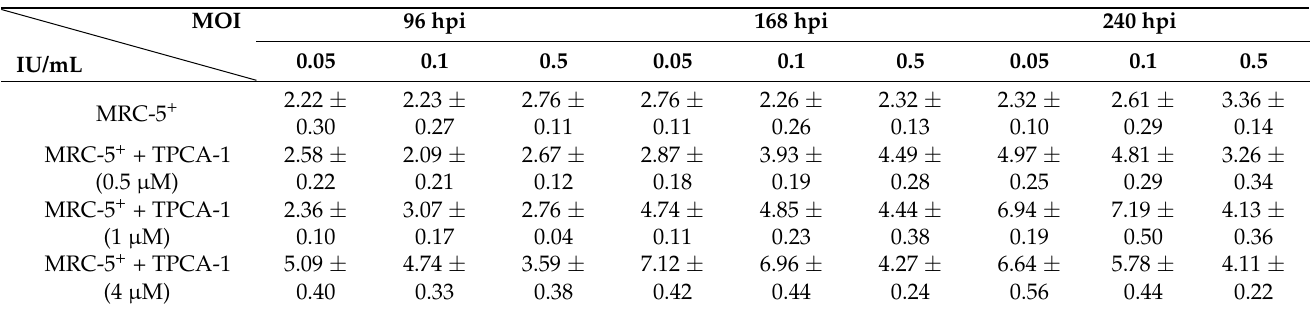
Figure 2. Treatment with IFN inhibitors enhanced RABV production in MRC-5 cells.MRC-5 cells were infected with the PM RABV strain at an MOI of 0.05. Vero cells were infected with the aG RABV strain at an MOI of 0.001. The MRC-5 cells were treated with 4 µ M TPCA-1 or ruxolitinib 2 h before RABV infection. ( A ) Total RNA from cells was extracted at 24 hpi, and the expression of IFN- α , IFN- β , STAT1, IRF7, and OAS1 was detected by qRT-PCR. RABV mRNA expression, antigen G concentration, and viral titer in culture supernatant were measured by qRT-PCR ( B ), enzyme-linked immune-sorbent assay (ELISA) ( C ), and focus-forming unit (FFU) assays ( D ), respectively, at 96, 168, and 240 hpi. + : RABV infection; * p < 0.05; ** p < 0.01, *** p < 0.001; **** p < 0.0001; ns p ≥ 0.05. Table 3. Supernatant rabies virus (RABV) antigen G concentration (IU/mL) at various time points post infection in MRC-5 with TPCA-1 treatment.